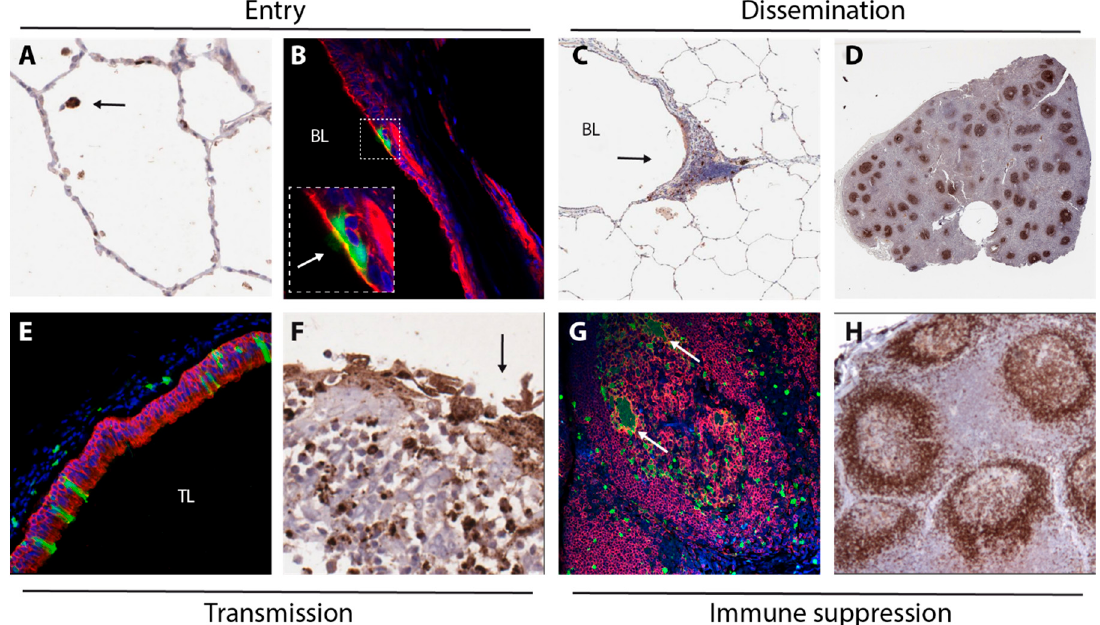
Figure 4. Images collected from experimentally infected NHPs, illustration mechanisms underlying MV entry ( A , B ), dissemination ( C , D ), transmission ( E , F ) and immune suppression ( G , H ). MV-infected cells were detected by immunohistochemical staining ( A , C , D , F ) or by immunofluorescent double-staining ( B , E , G ). ( A ) infection of a single cell (arrow, likely an alveolar macrophage) in the alveolar lumen 3 DPI; ( B ) infection of epithelial cells in the trachea 5 DPI (arrow in insert points at green cilia), green = GFP, red = cytokeratin, blue = DAPI; ( C ) infection of myeloid and lymphoid cells in BALT (arrow) 4 DPI, BL = bronchial lumen; ( D ) low-magnification image of a lymph node 9 DPI, with many B-cell follicles containing large concentrations of MV-infected lymphocytes; ( E ) MV-infected epithelial cells in the trachea 9 DPI (green = GFP, red = cytokeratin, blue = DAPI, TL = tracheal lumen); ( F ) Disruption of the epithelium (arrow) of an adenoid containing many MV-infected lymphocytes 9 DPI; ( G ) MV-infected B-lymphocytes (including Warthin-Finkeldey syncytia, arrows) in a B-cell follicle 9 DPI (green = GFP, red = CD20, blue = DAPI); ( H ) follicular exhaustion of B-cell follicles 11 DPI (brown = CD20).